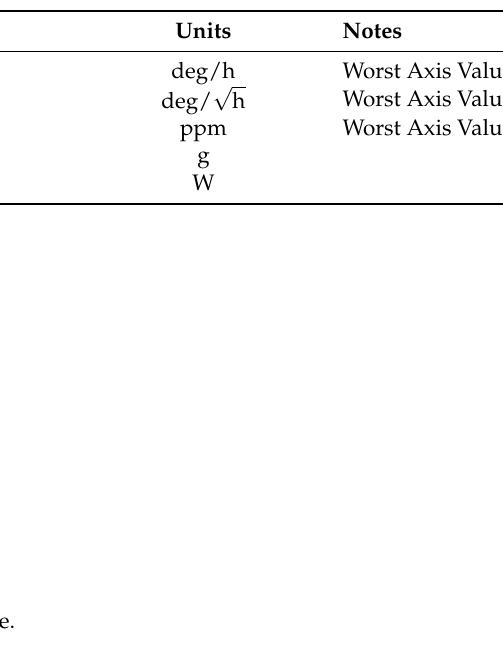
Table 3. Invensense MPU3300 gyroscope specifications.